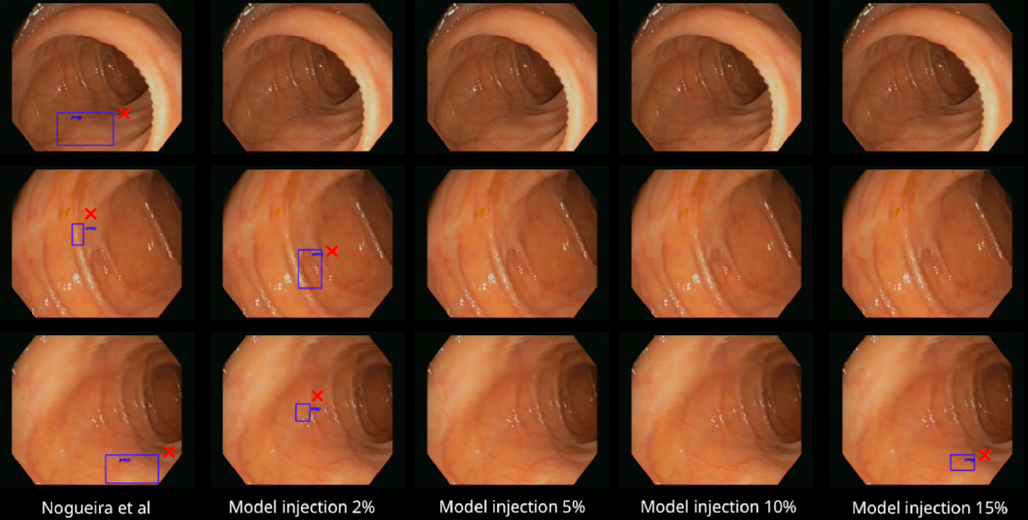
Figure 8 . The five models with three sample frames of the not-polyp video segment analyzed (Supplementary Video S2). While the baseline model makes incorrect predictions (red cross marks) in the three cases, most of the not-polyp-trained models do not [11].